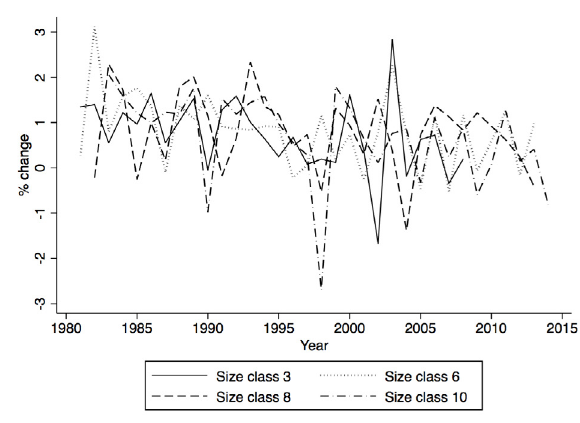
Figure 3. TFP change for four size classes (3,6,8,10) from Model